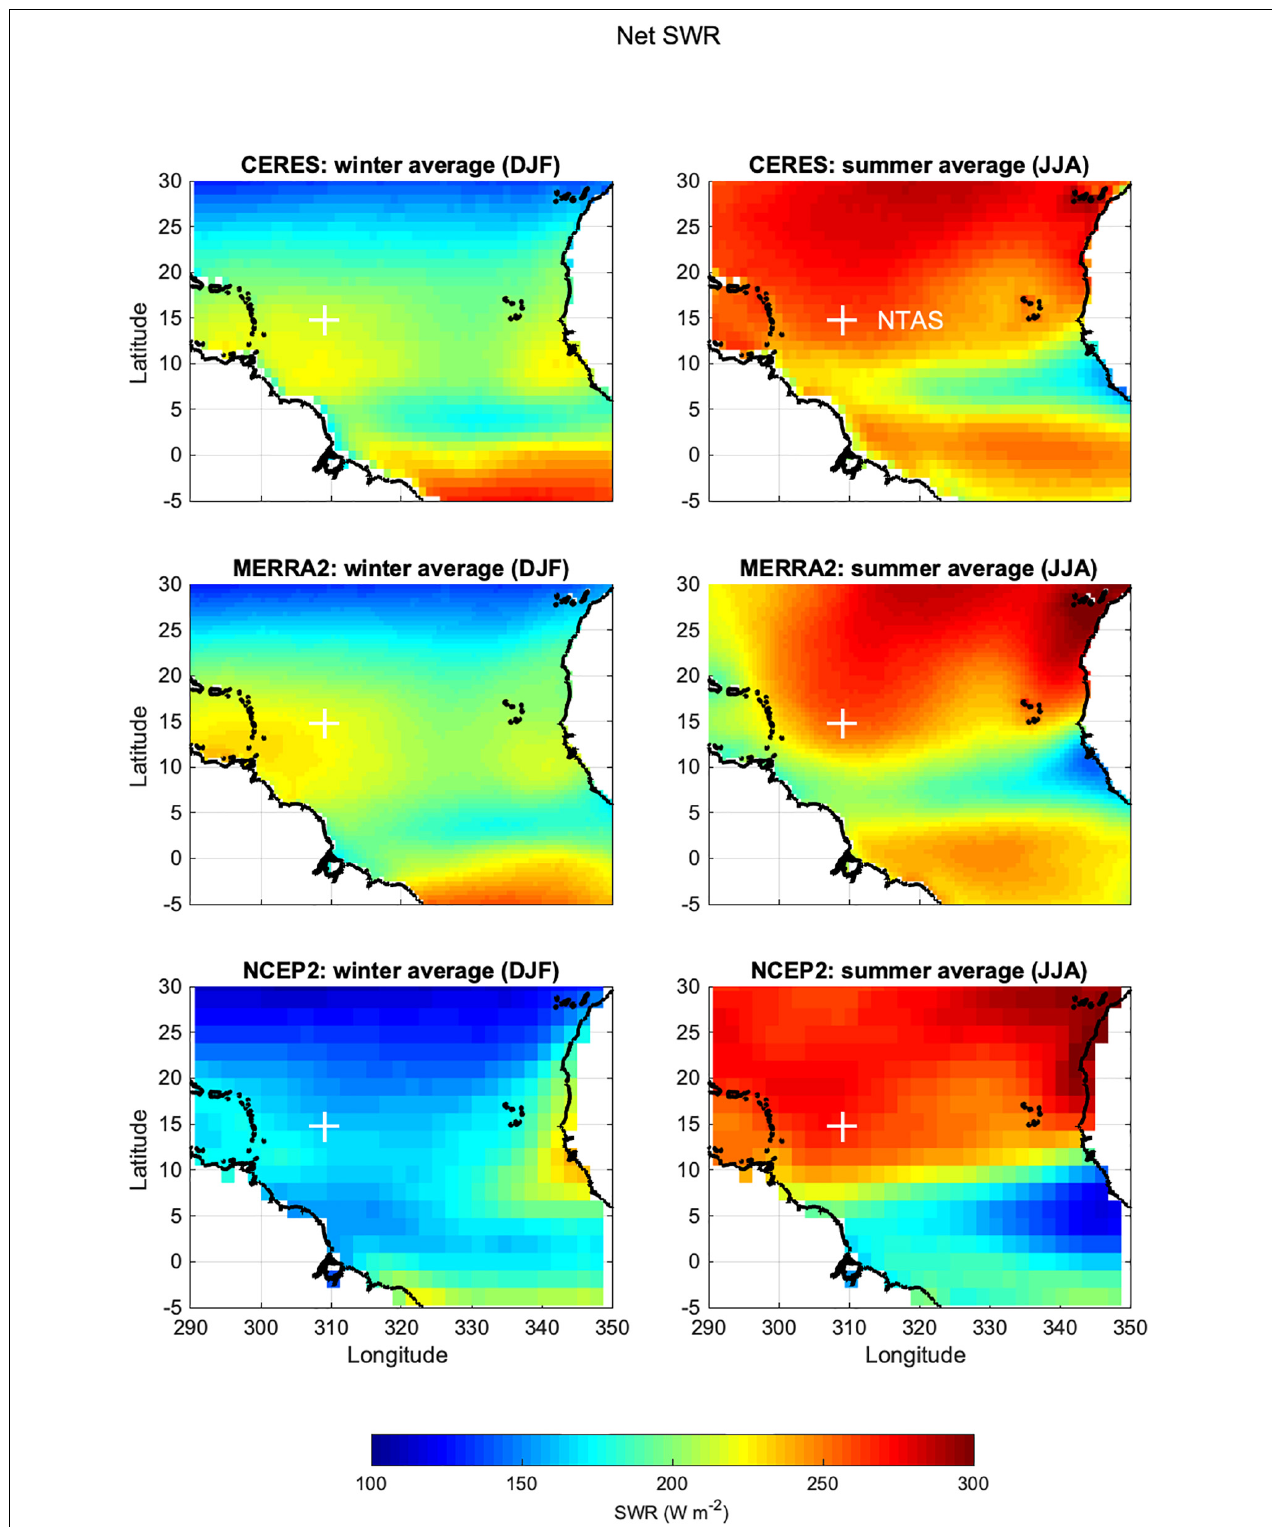
FIGURE 4 | Maps of seasonal climatology from years 2002 to 2011 in the tropical Atlantic: net shortwave radiation flux at the surface (in W m - 2 ), during boreal winter months (left) and summer (right). CERES (top row), MERRA-2 (middle row) and NCEP-2 (bottom row).